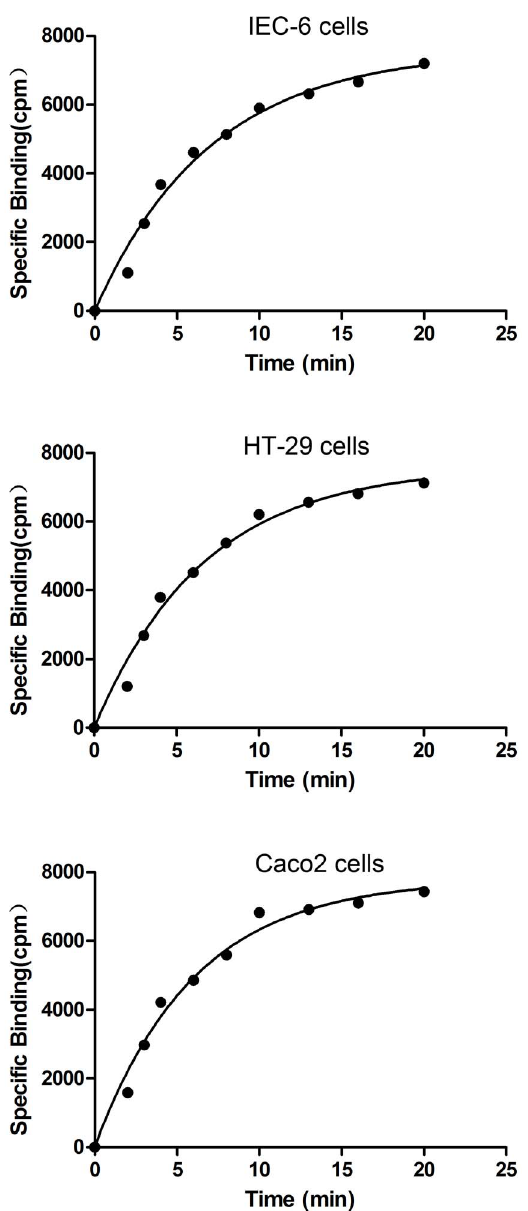
Figure 3. Association of ITF with epithelial cells.